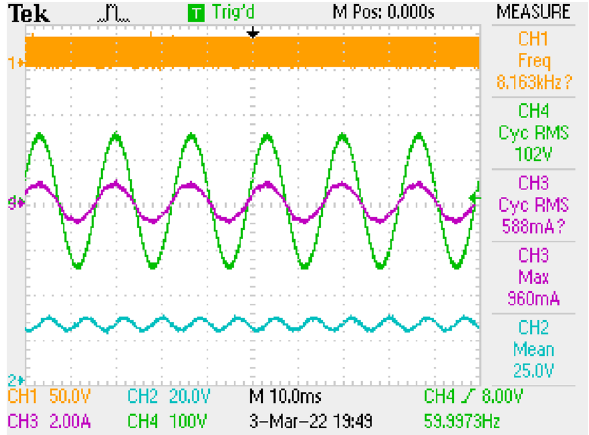
Figure 22. PWM, voltage-current of grid, voltage of output by π DM filter.